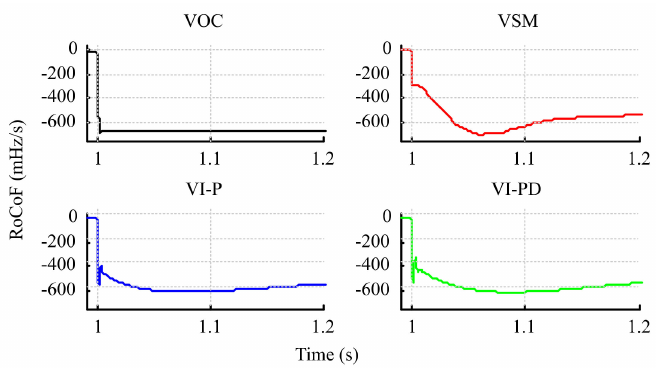
Figure 14. Zoom of the RoCoF ∆ t variation on the load change.